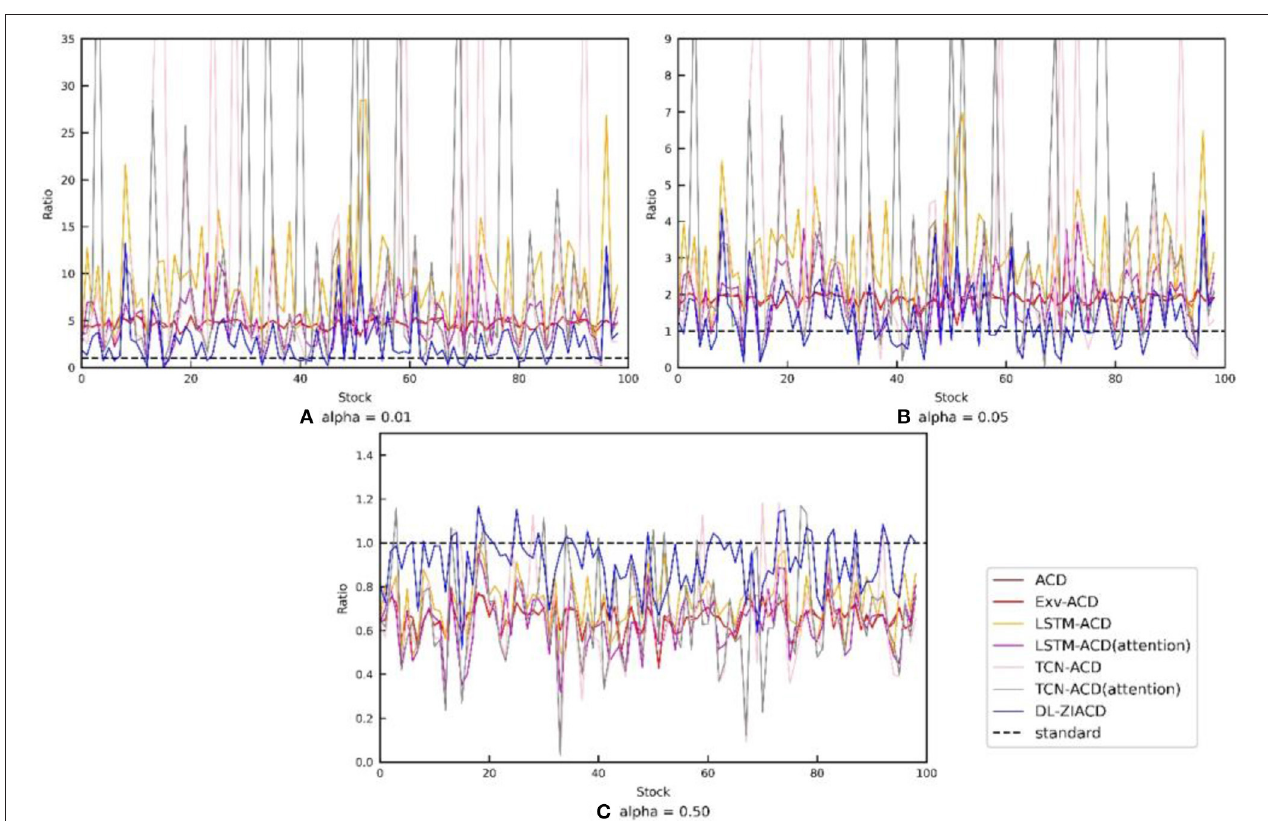
FIGURE 4 | Detailed comparison of the 7 models in R α = ∧ α/α by a line chart. (Each full line is plotted by connecting the R α value from the corresponding model on each stock, while each black dotted line is a horizontal line at 1 value).